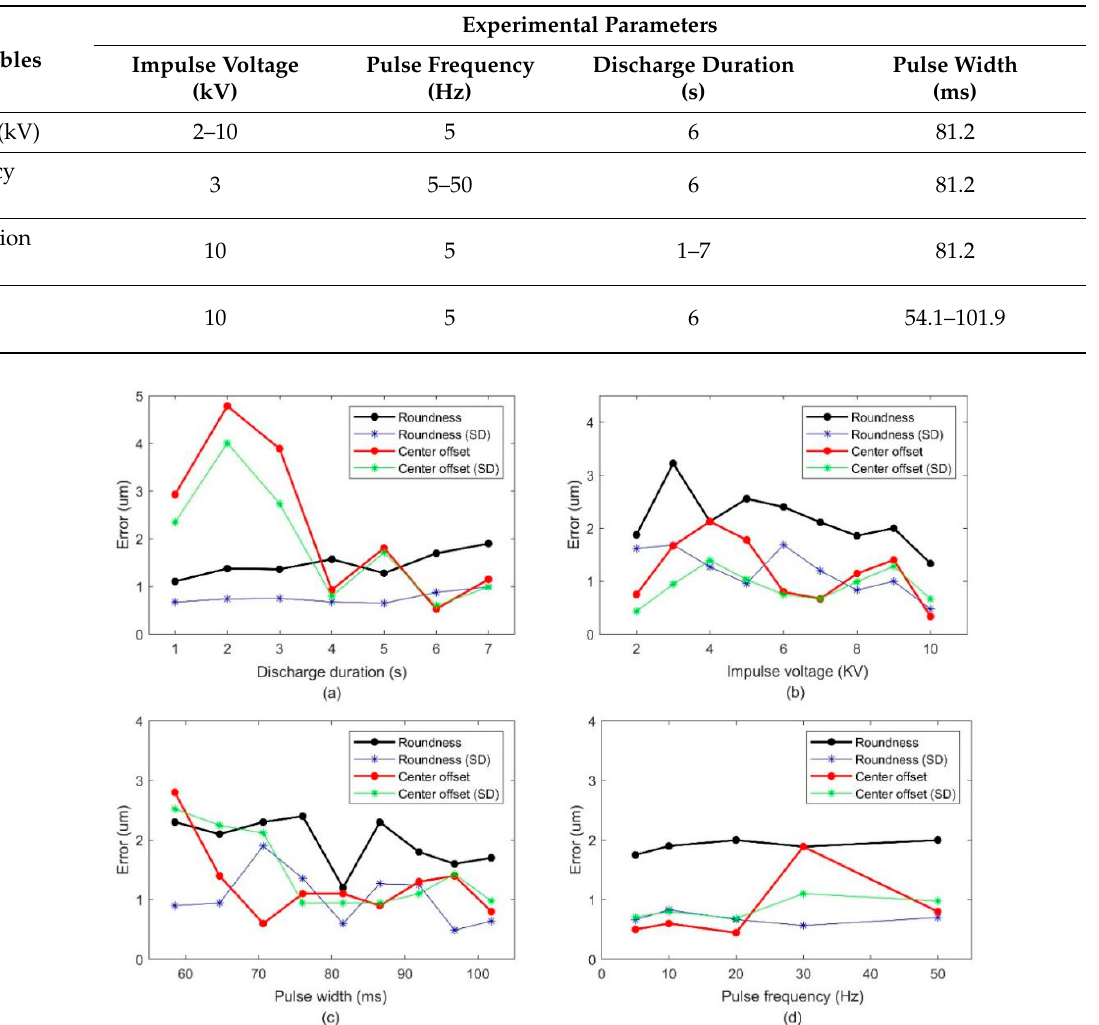
Figure 3. Relationship between the roundness error, center offset error, and process parameters.